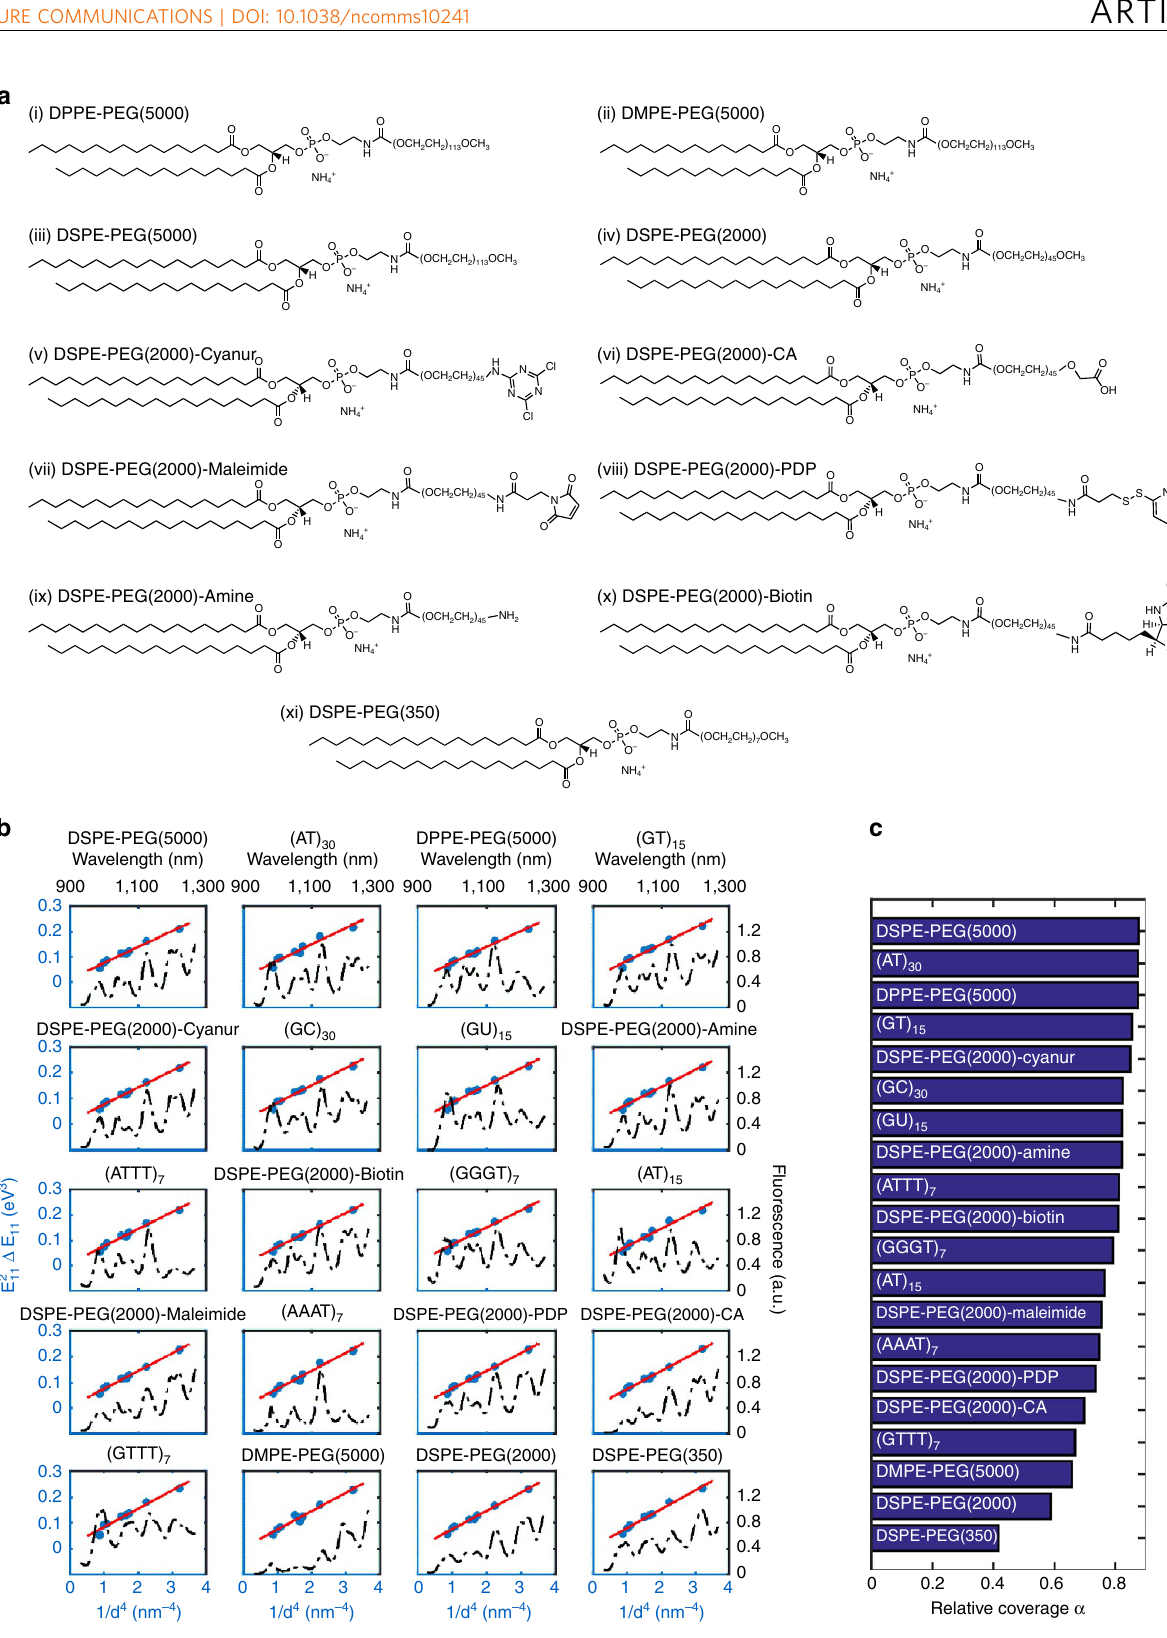
Figure 1 | SWCNT suspension library. ( a ) The structure of the phospholipid-PEG constructs used in this study to suspend the SWCNT. (i) DPPE- PEG(5000), (ii) DMPE-PEG(5000), (iii) DSPE-PEG(5000), (iv) DSPE-PEG(2000), (v) DSPE-PEG(2000)-Cyanur, (vi) DSPE-PEG(2000)-carboxylic acid (CA), (vii) DSPE-PEG(2000)-Maleimide, (viii) DSPE-PEG(2000)-[3-(2-Pyridyldithio)-propionyl] (PDP), (ix) DSPE-PEG(2000)-Amine, (x) DSPE- PEG(2000)-Biotin, (xi) DSPE-PEG(350). The number in parentheses is the molecular weight of the PEG chain in Daltons. ( b ) The solvatochromic shift as a function of the SWCNTdiameter to the power of negative 4 ( d (cid:2) 4 , blue dots) and its linear fit (solid red curve), and the fluorescent emission intensity for each wrapping (dashed black curve). ( c ) The relative surface coverage of the polymer wrappings ranked in descending